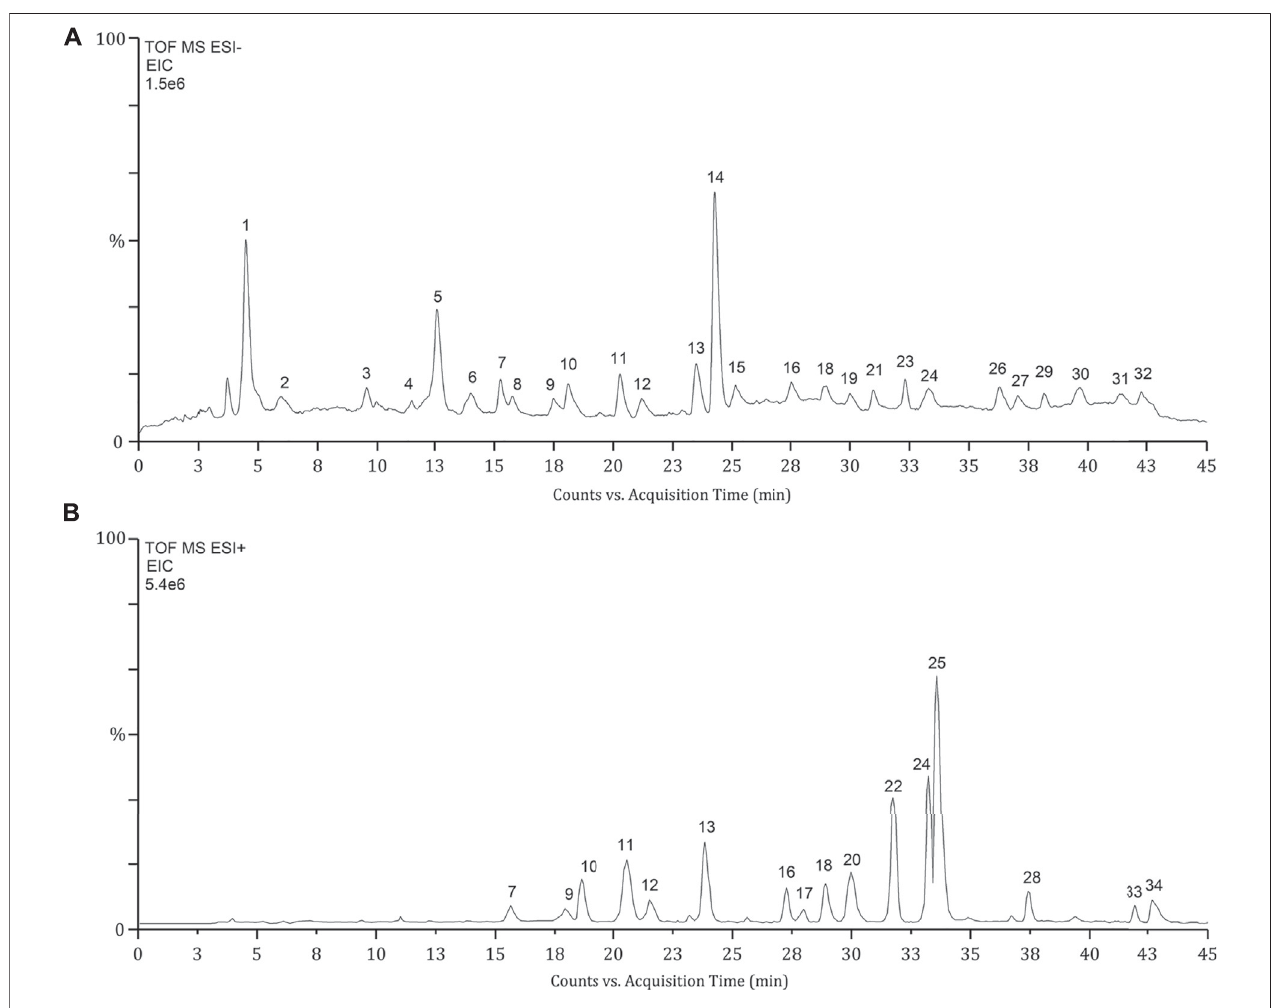
FIGURE 1 | Extracted ion chromatograms (EIC) of OSB samples obtained from LC-Q/TOF-MS analysis. EIC of OSB extract samples in negative mode (A) and positive mode (B) . LC-Q/TOF-MS, liquid chromatography coupled with quadrupole time-of- fl ight mass spectrometry; OSB, Orthosiphon stamineus Benth.